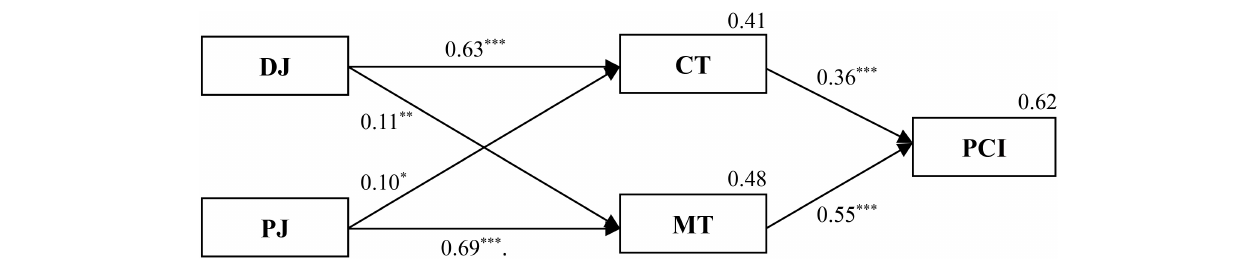
Test of Mediation